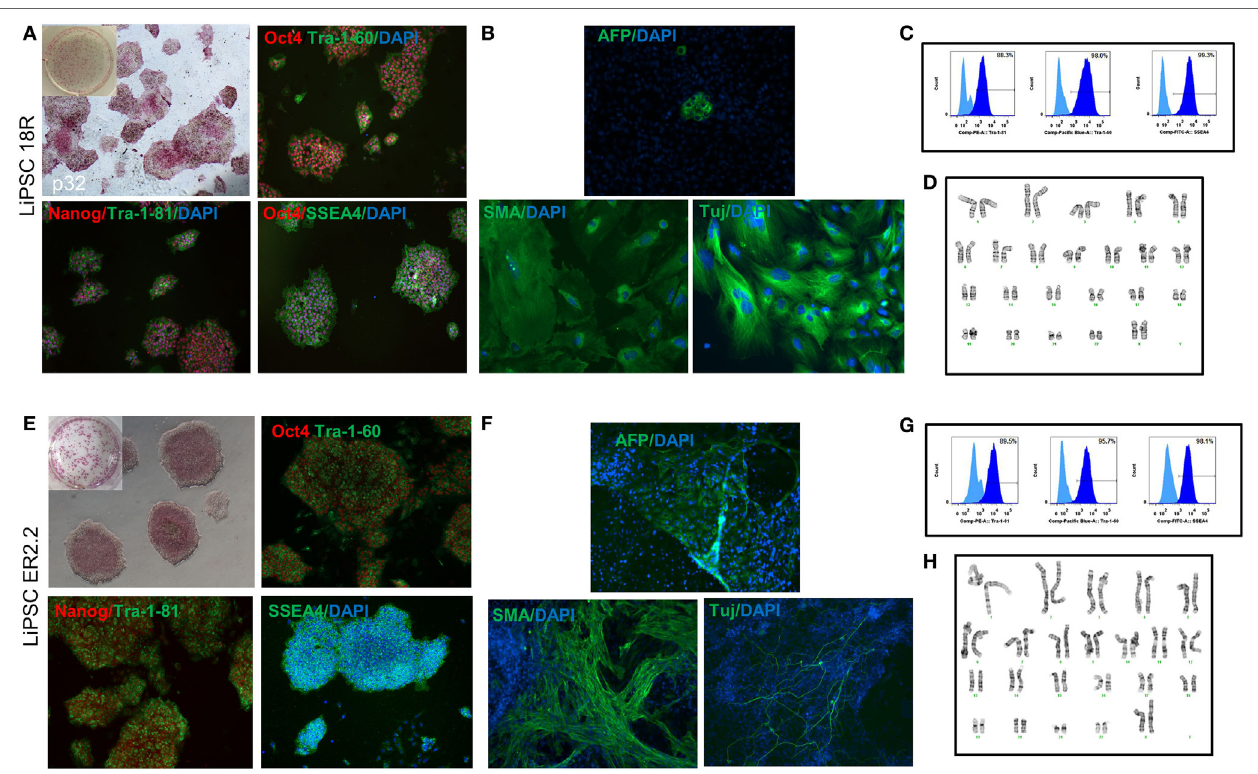
FigUre 1 | Characterization of current good manufacturing practice-compliant human-induced pluripotent stem cell (hiPSC) lines (LiPSC 18R and LiPSC ER2.2). (a) LiPSC 18R positively stained with pluripotency specific markers Oct4, Nanog, Tra-1-81, SSEA4, and Tra-1-60. hiPSCs were also positive for alkaline phosphatase (AP) (top left). (B) LiPSC 18R were induced to spontaneously differentiate into three germ layers through embryoid bodies (EB) formation. Differentiated cells expressed the markers for endoderm [Alpha-Feto Protein (AFP)], mesoderm [Smooth Muscle Actin (SMA)], and early ectoderm (beta-III-Tubulin or TUJ1). (c) Flow-cytometry analysis showed that the LiPSC 18R expressed the pluripotent stem cell surface markers including TRA-1-60, SSEA-4, and TRA-1-81 (dark blue). Light blue exhibits the isotype control. (D) LiPSC 18R demonstrated normal karyotype after eight passages in culture as shown by G-banding analysis. (e) LiPSC ER2.2 positively stained with pluripotency specific markers Oct4, Nanog, Tra-1-81, SSEA4, and Tra-1-60. hiPSCs were also positive for alkaline phosphatase (AP) (top left). (F) LiPSC ER2.2 were induced to spontaneously differentiate into three germ layers through EB formation. Differentiated cells expressed the markers for endoderm (AFP), mesoderm (SMA), and early ectoderm (beta-III-Tubulin or TUJ1). (g) Flow-cytometry analysis showed that the LiPSC ER2.2 expressed the pluripotent stem cell surface markers including TRA-1-60, SSEA-4, and TRA-1-81 (dark blue). (h) LiPSC 18R demonstrated normal karyotype after 15 passages in culture as shown by G-banding